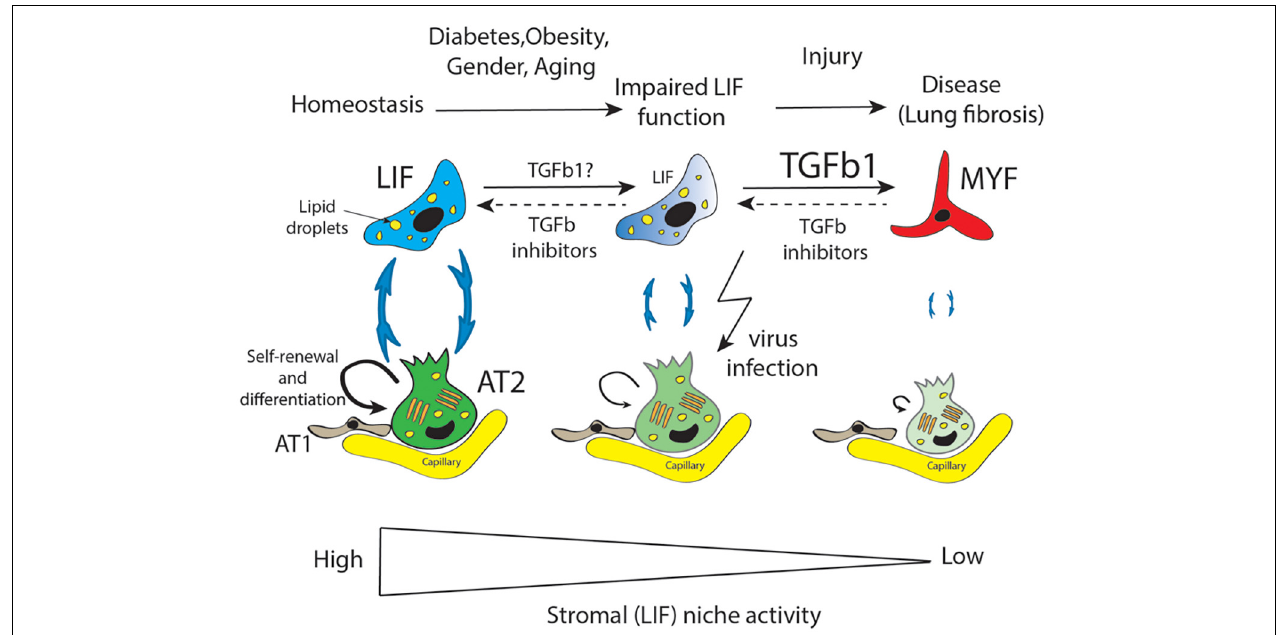
FIGURE 2 | LIF is an important mesenchymal population supporting AT2 stem cells in terms of self-renewal and differentiation to AT1 cells. LIF cells provide triglycerides to AT2 for the elaboration of surfactant. Diabetes, obesity, aging, and gender are proposed to be the main factors impacting negatively the mesenchymal/stromal (LIF) niche activity resulting in decreased AT2-LIF interaction. Against this background, further injury to the lung leads the impaired LIF to transdifferentiate to activate myofibroblast (MYF). Accumulation of MYF is a main characteristic of lung fibrosis which over time, in particular in old males, leads to failure of lung function. Moreover, AT2 cells are the main target of virus infection which drastically reduces their function in terms of surfactant protein production. TGF β is a causative growth factor for fibrosis induction and maintenance. We propose that TGF β inhibitors could be instrumental in restoring impaired LIF function in the context of diabetes, obesity, gender, and aging as well as in the MYF to LIF transdifferentiation in the context of